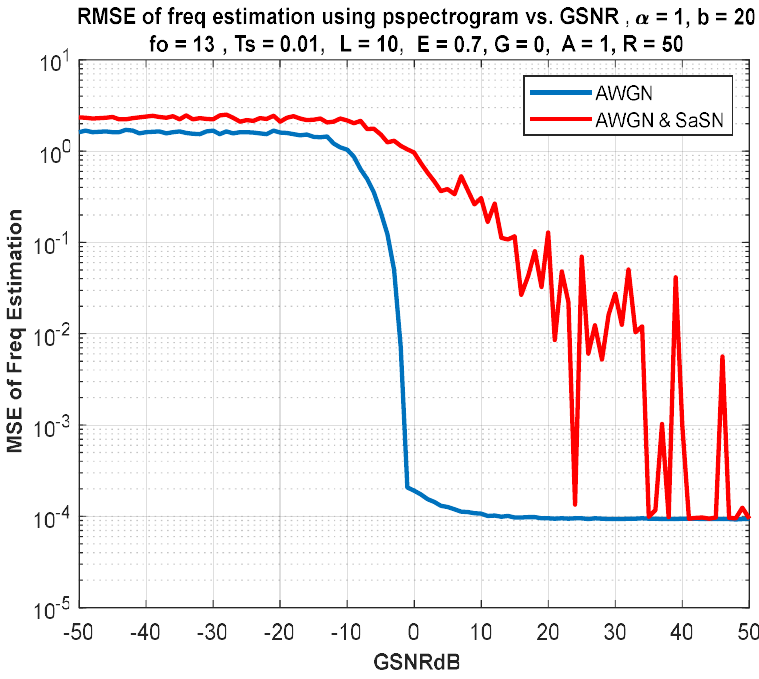
Figure 28. MSE versus GSNR for TFD of noisy LFM signal by pspectrum, where α = 1 and b = 20.